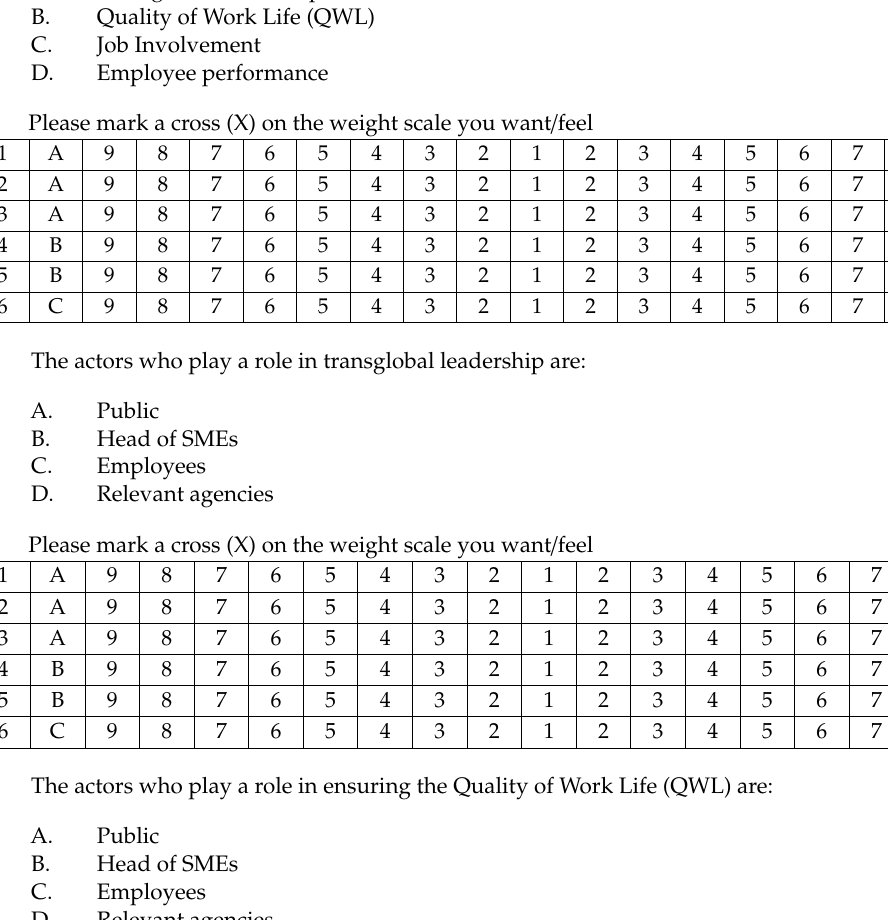
Figure A11. Bar Diagram of Gap Analysis of Overall.